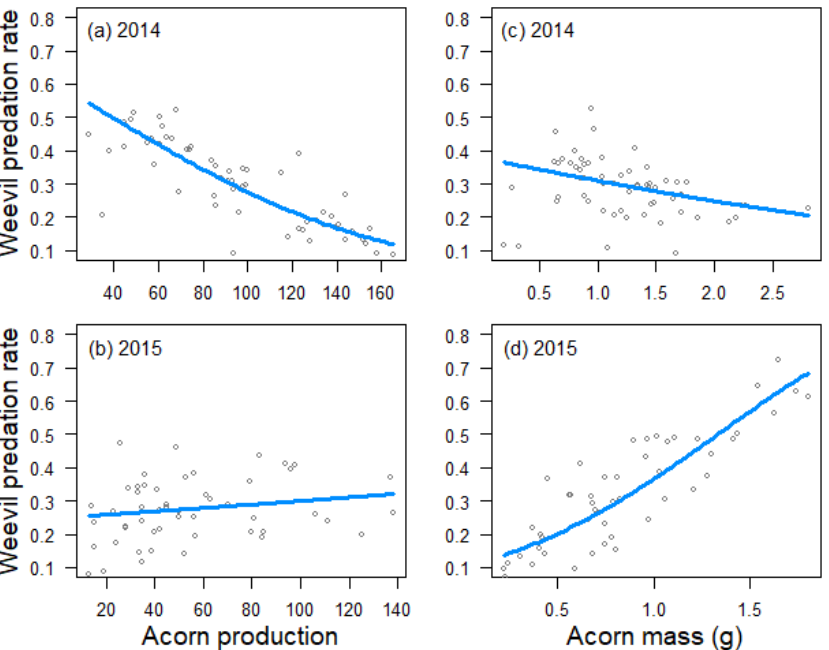
Figure 1. Relationship between tree crop size and weevil predation rate in 2014 ( a ) and 2015 ( b ), and between tree acorn mass and weevil predation rate in 2014 ( c ) and 2015 ( d ), as estimated by generalized linear models. Trend lines fitted to data from 59 Quercus faginea trees in 2014 and 51 trees in 2015.